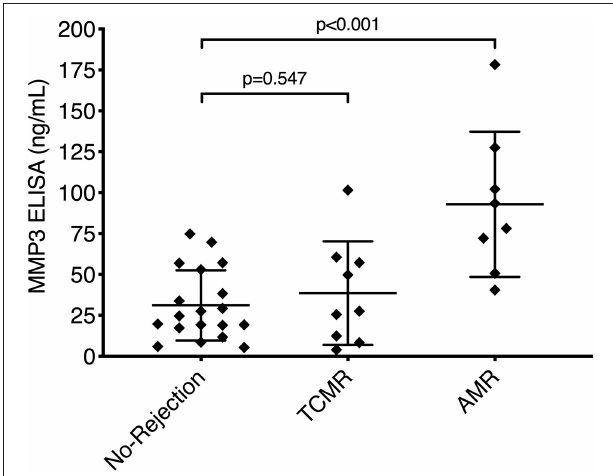
FIGURE 2 | MMP3 levels in kidney transplantation. Serum levels of MMP3 from 36 kidney transplant recipients were measured during no-rejection ( n = 19), TCMR ( n = 9), and AMR ( n = 8) episodes. There was a significant increase ( p < 0.001) of MMP3 during AMR but not TCMR, as compared to no-rejection episodes. Data is presented as scatter dot plot showing every individual value. Mean and standard deviation are displayed as long and short